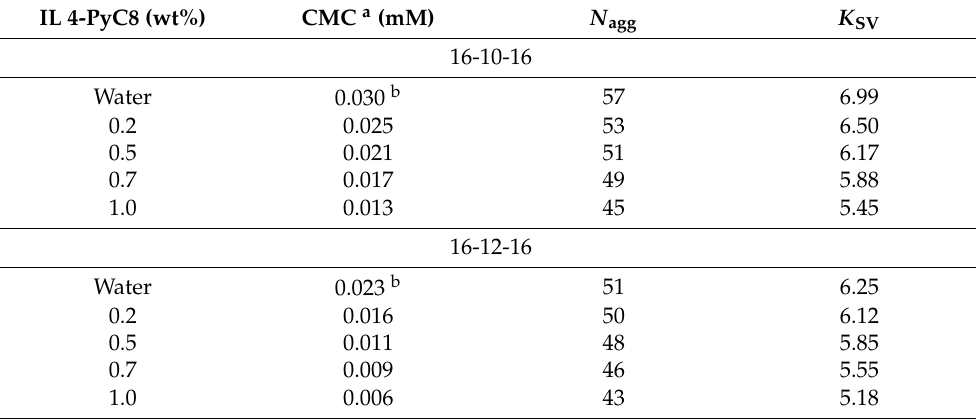
Table 4. Critical micelle concentration (CMC), aggregation number ( N agg ) and Stern–Volmer constants ( K SV ) of the two gemini surfactants 16-10-16 and 16-12-16 in water and in the presence of 0.2, 0.5, 0.7 and 1.0 wt% of the IL 4-PyC8 at 300 K. IL 4-PyC8